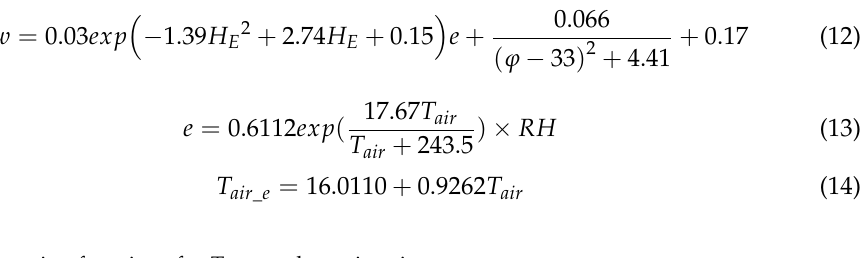
Table 3. Regression functions for T air_e and τ